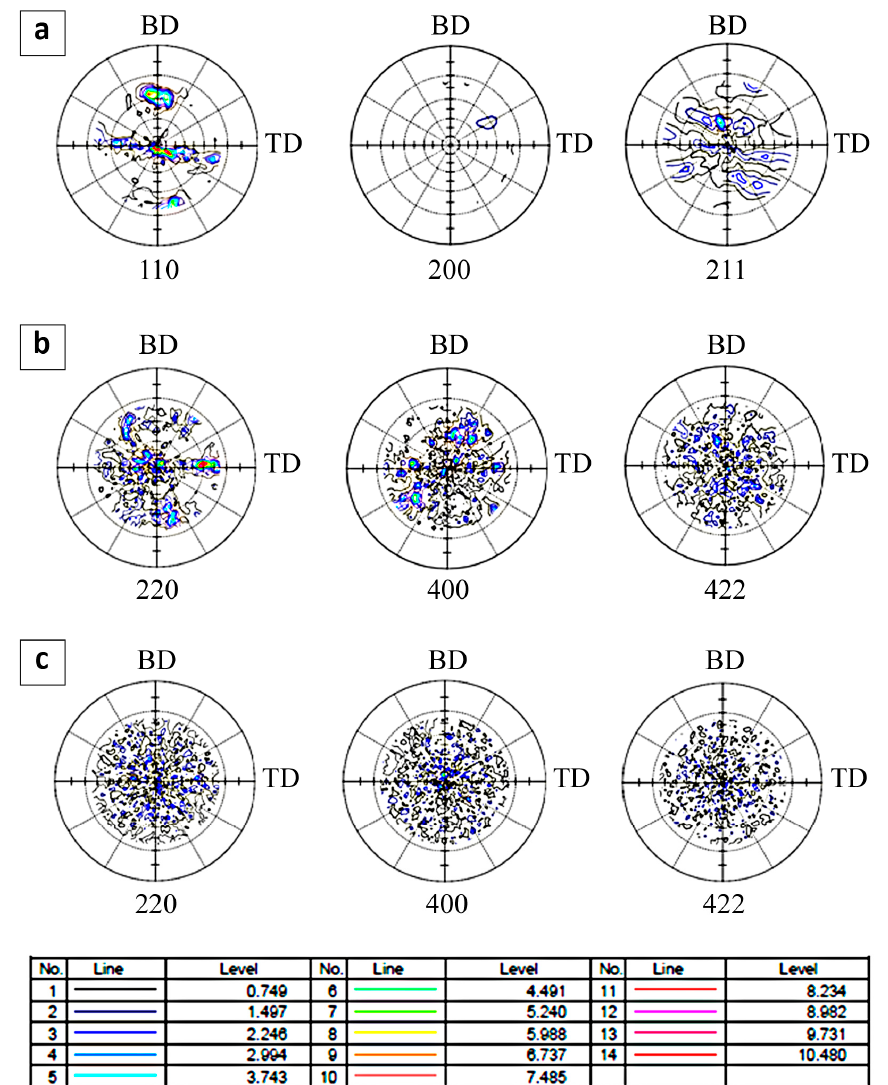
Figure 8. Incomplete pole figures and the legend of normalized intensity for the samples made at ( a ) low (0.6 × 10 4 K/s), ( b ) medium (1.8 × 10 4 K/s), and ( c ) high cooling rates (2.8 × 10 4 K/s).